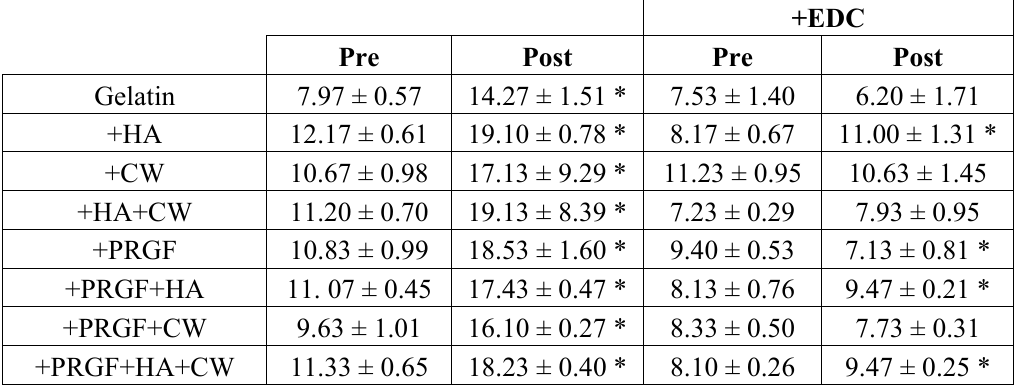
Table 2. Mass (mg) of dry scaffolds pre/post-incubation. * denotes post-culture mass is statistically different ( p < 0.05) than pre-culture